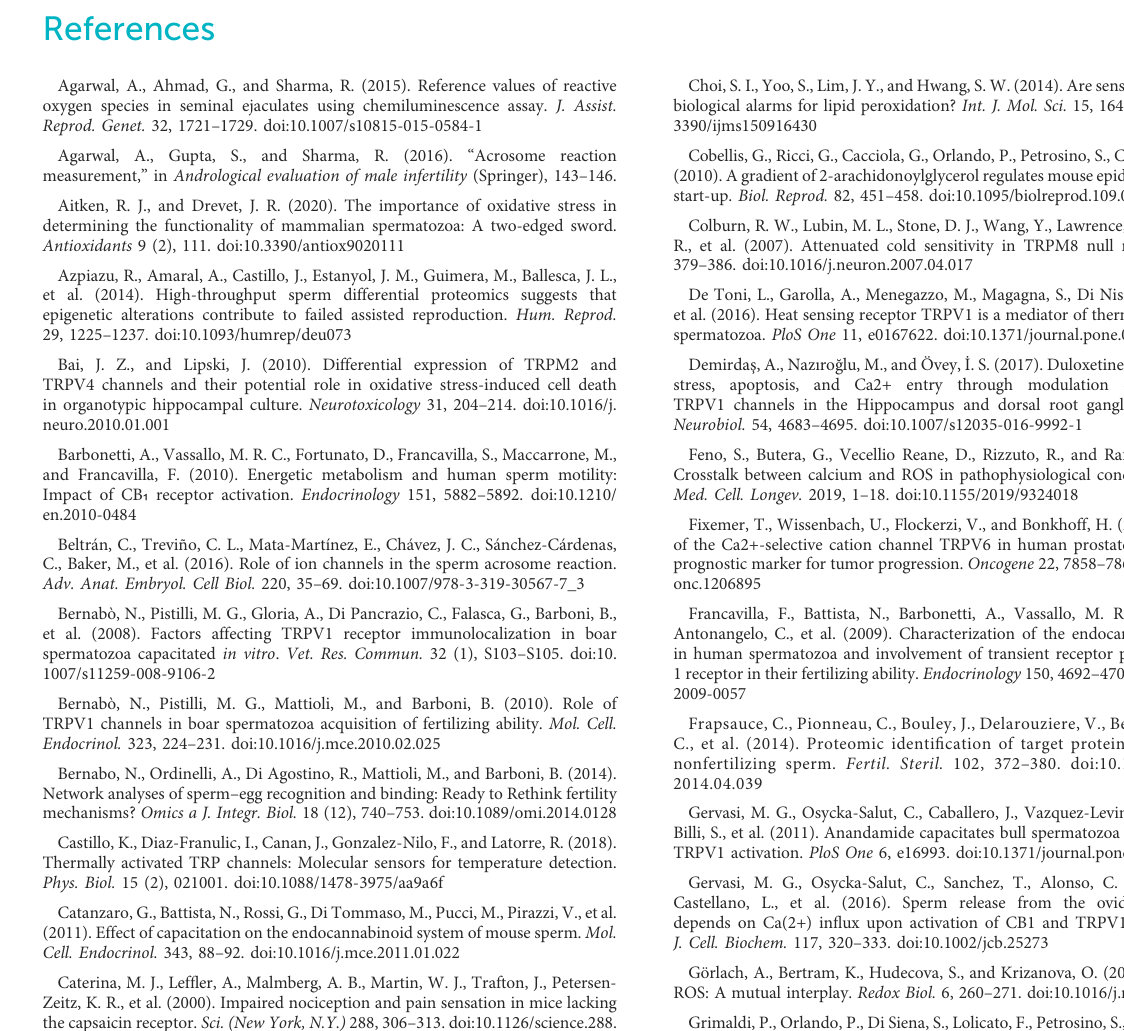
SUPPLEMENTARY FIGURE S1 Immunising peptide blocking assay to validate the effectiveness of the antibody.